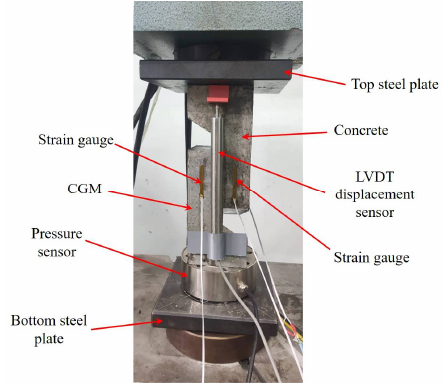
Figure 4. Cell for direct shear